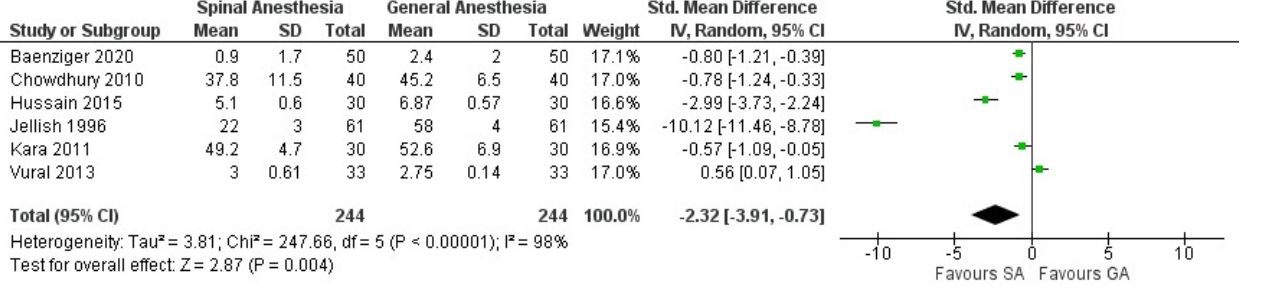
Figure 4. Trial Sequential Analysis of postoperative pain. Notably, in a post-hoc analysis evaluating pain at 24 h after surgery, there were no di ff erences among the groups (SMD: − 0.33, 95% CI: − 0.69 to 0.04, p : 0.08, I 2 : 60%) [15,20– 22] (Figure S1). Only two studies reported the pain before the surgery [22,23], for this reason, we were not able to perform any further analysis. 4.2. Secondary Outcomes All the secondary outcomes analysis discussed below are available as supplementary material for both forest plots ( see Supplemental Digital Content 5) and TSA ( see Figure S2).